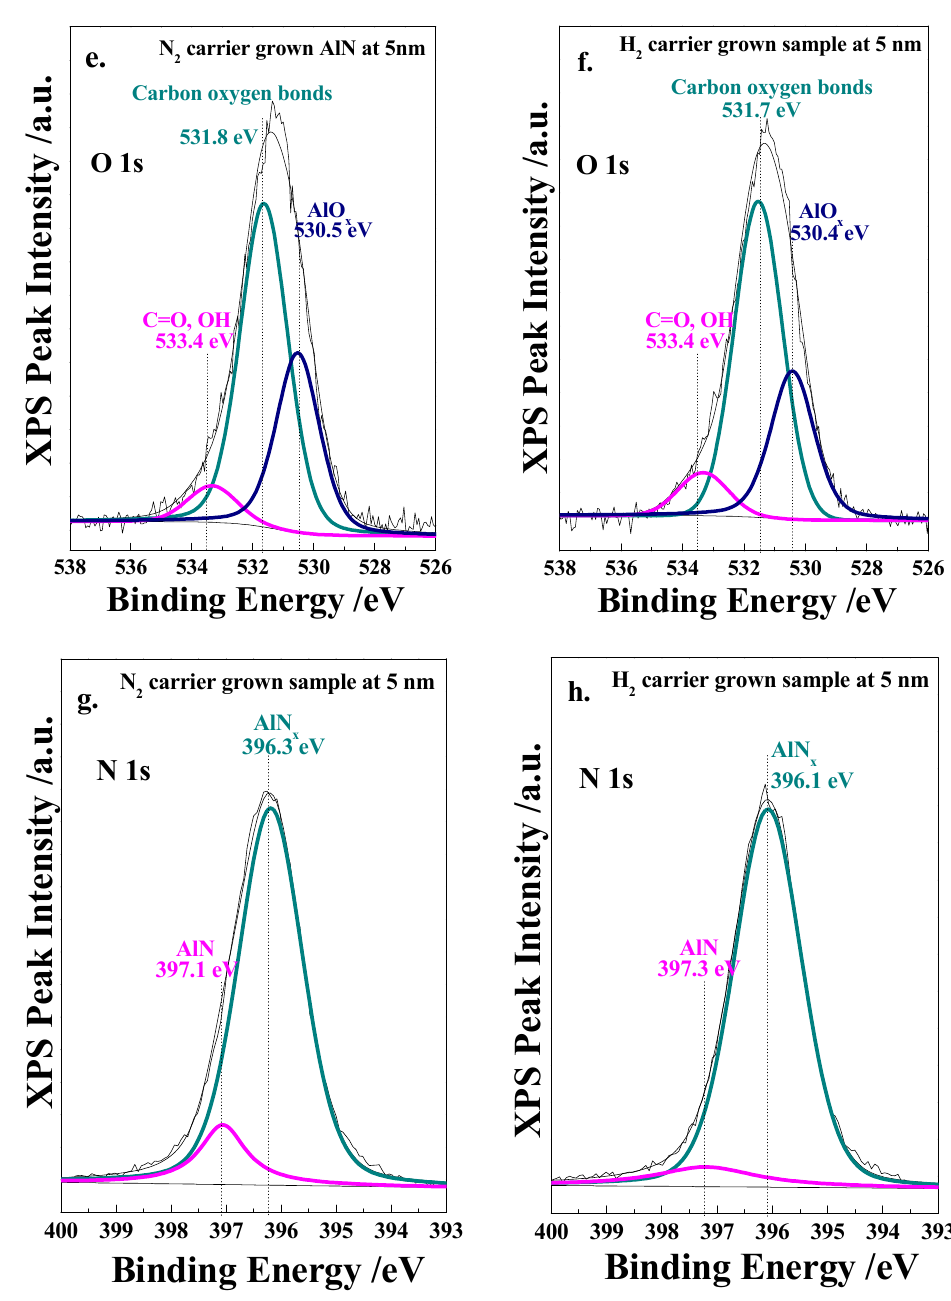
Figure 5. Comparison of high-resolution XPS spectra of AlN showing the chemical states of C1s grown with ( a ) N 2 , ( b ) H 2 , Al2p grown with ( c ) N 2 , ( d ) H 2 ; O1s with ( e ) N 2 , ( f ) H 2 ; and N1s with ( g ) N 2 , ( h ) H 2 carrier gases. Table 1. Atomic concentration (AC) of AlN samples at the depth of 5 nm grown in N 2 and H 2 environments as calculated by quantification of the XPS